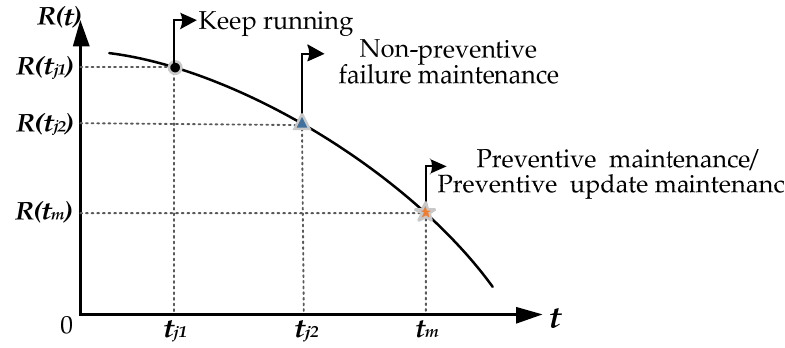
Figure 1. Corresponding relationship between reliability and running time of component.